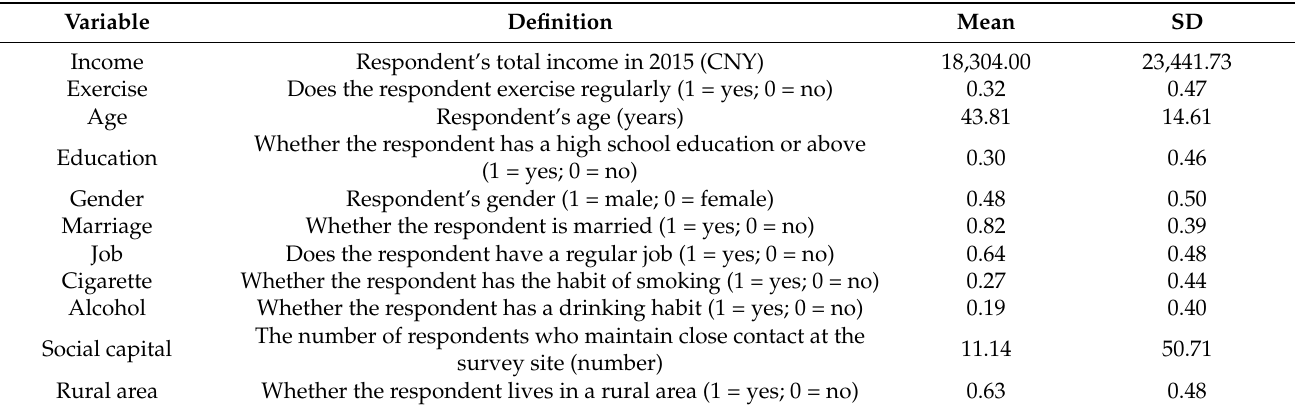
Table 1. Variable definition and descriptive